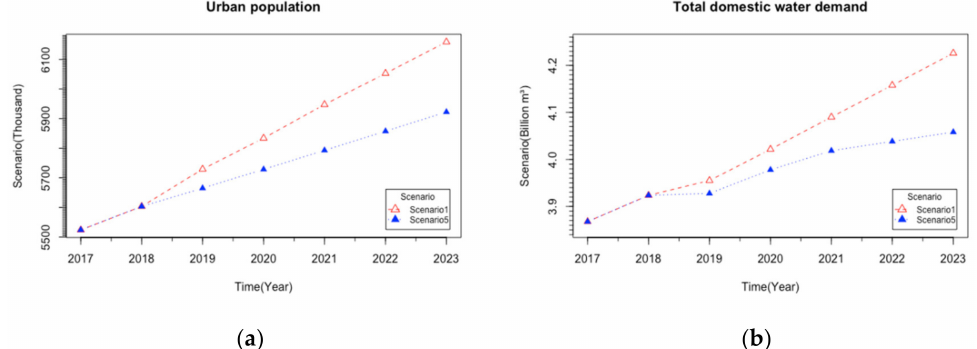
Figure 12. Scenario 5 simulation results: ( a ) Trend of urban population; ( b ) Trend of total domestic water